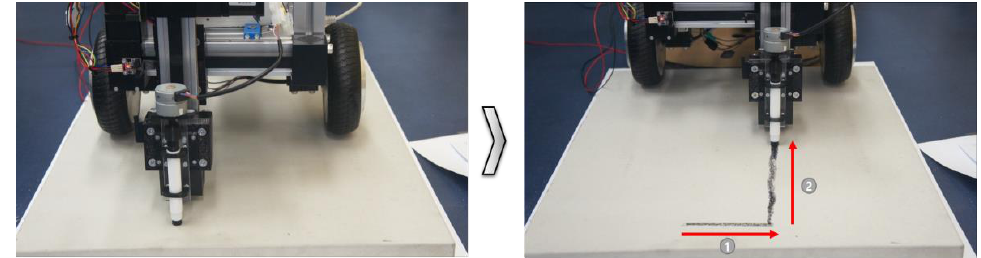
Figure 13. Before and after the concrete floor surface marking functionality test.